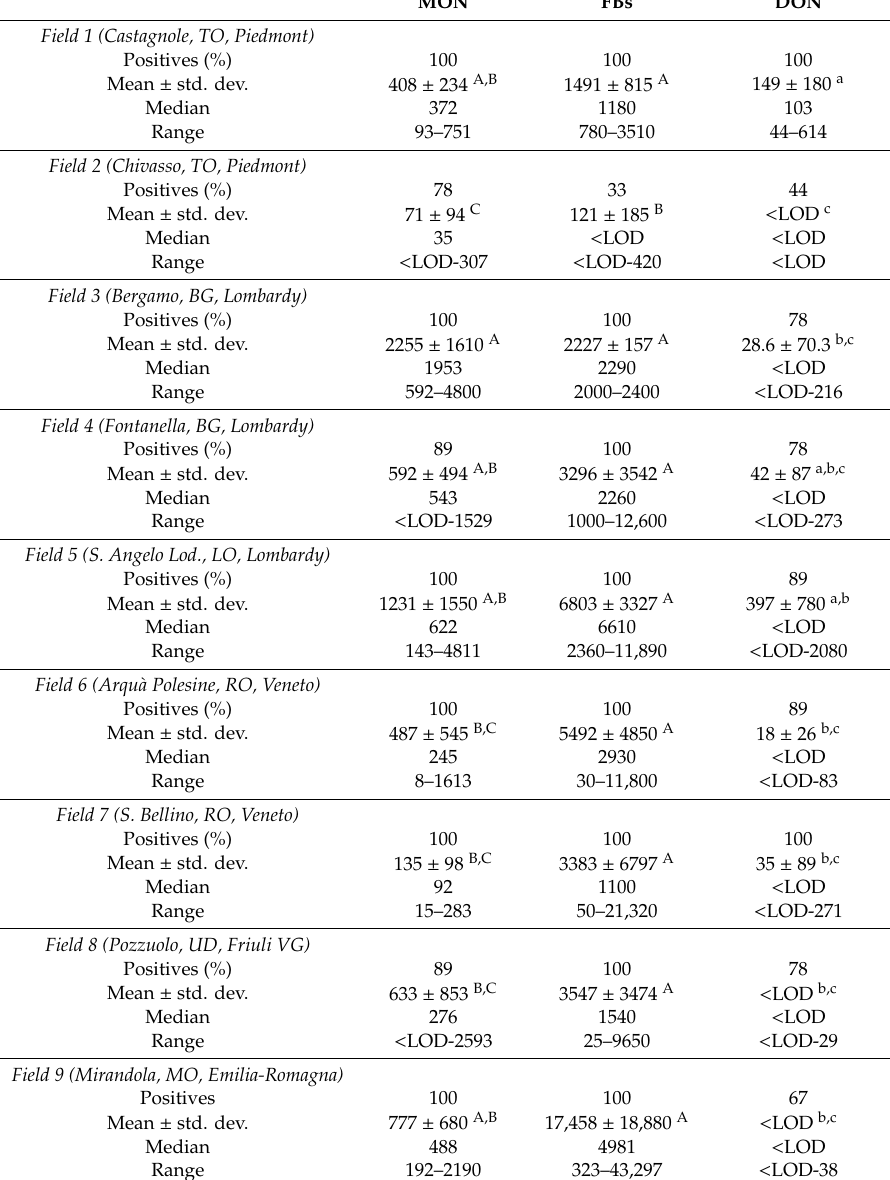
Table 1. Descriptive statistics of moniliformin (MON), fumonisins (FBs), and deoxynivalenol (DON) contamination ( µ g kg − 1 ) for maize samples collected in Northern Italy in 2018. MON FBs Field 1 (Castagnole, TO, Piedmont) Positives